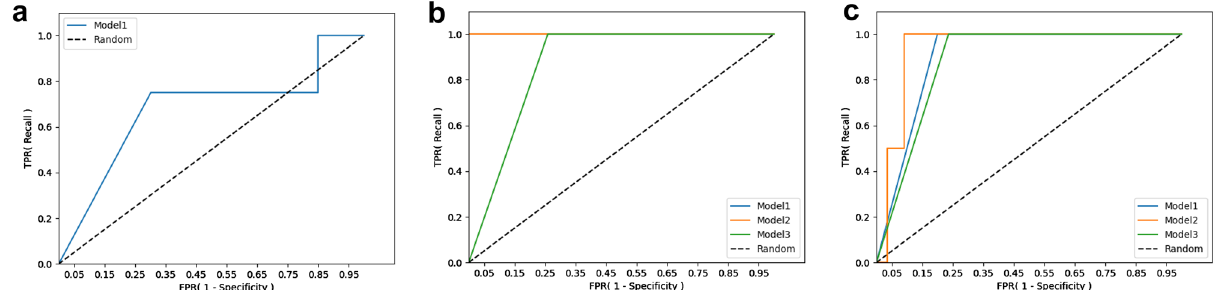
Figure 3. Receiver operating characteristic curves of proposed ML models from 57 test cases. ( a ) NEC prediction, ( b ) NEC-IP prediction, and ( c ) SIP prediction.